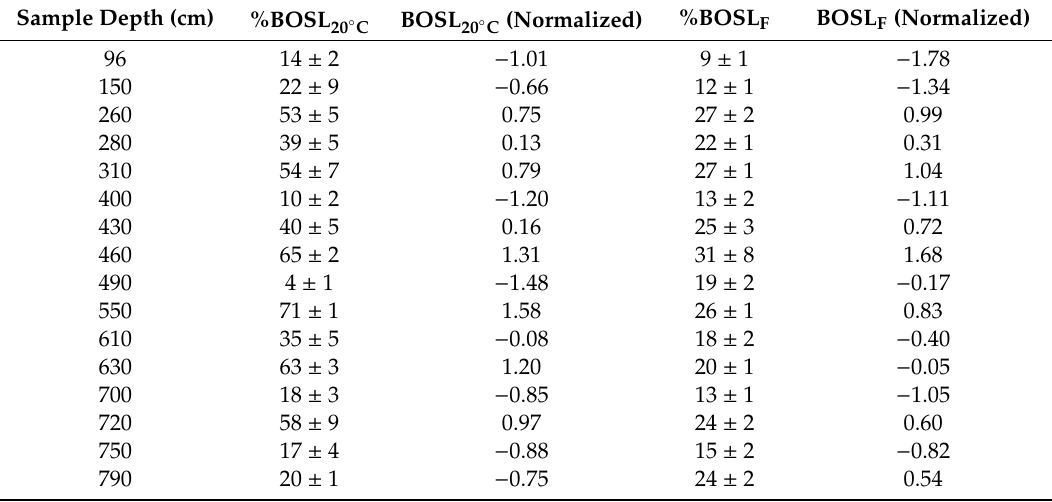
Table 7. Comparison between BOSL F sensitivity [30] and sensitivity measured at room temperature (BOSL 20 ◦ C ) for silt aliquots from GeoB16206-1 sediment core. Sensitivity values correspond to the average of three aliquots ( ± standard deviation). Data normalization included subtraction of mean and division by the standard deviation of the data set (%BOSL 20 ◦ C or %BOSL F